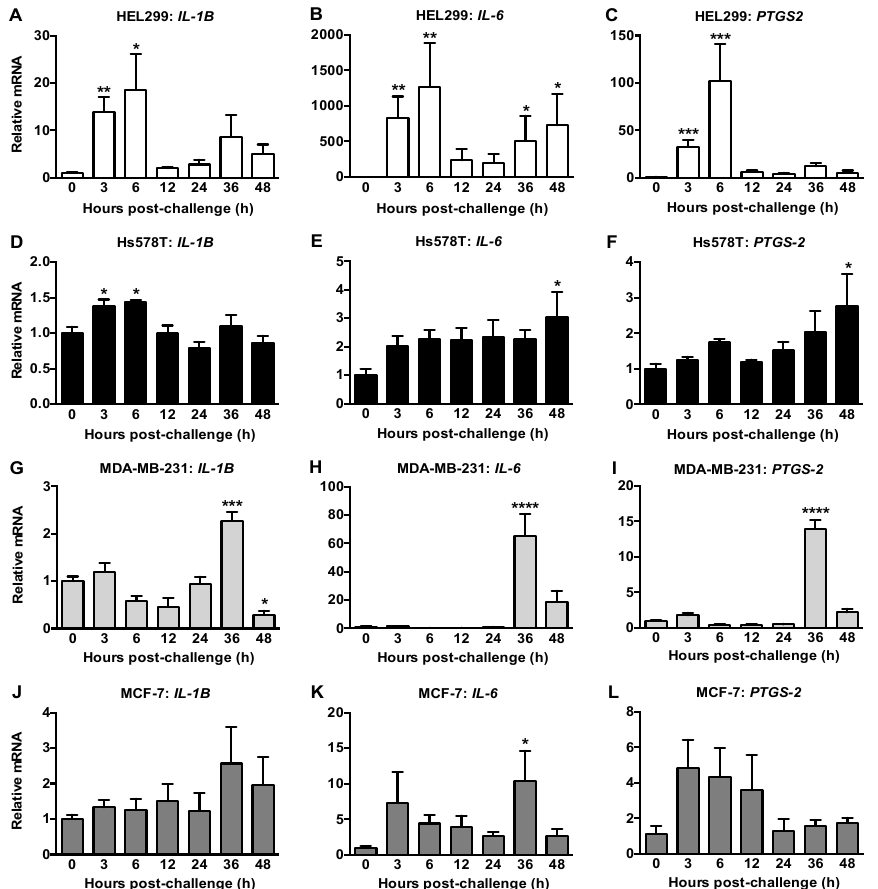
Figure 4. Proinflammatory mRNA expression was differentially increased in HEL299 fibroblasts and breast cancer cells exposed to HCMV. HEL299 fibroblasts ( A – C ) were exposed to HCMV at 1 MOI and Hs578T ( D – F ), MDA ‐ MB ‐ 231 ( G – I ) and MCF ‐ 7 ( J – L ) breast cancer cells were exposed to HCMV at 2 MOI. Lysates were collected and mRNA expression was measured. Results are expressed relative to lysates from cells treated with a filtered control at each timepoint and then normalized to 0 h. Results are means ± SEM from 3–5 independent experiments and P ‐ values were calculated by the nonparametric Kruskal ‐ Wallis test with a Dunn’s multiple comparisons test ( A – C ) or by one ‐ way ANOVA if the analyses passed the Brown Forsythe test ( D – L ). *, P < 0.05; **, P < 0.01; ***, P < 0.001; ****, P < 0.0001.